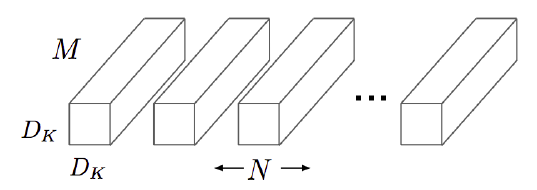
Figure 4. Standard convolution kernels [14].